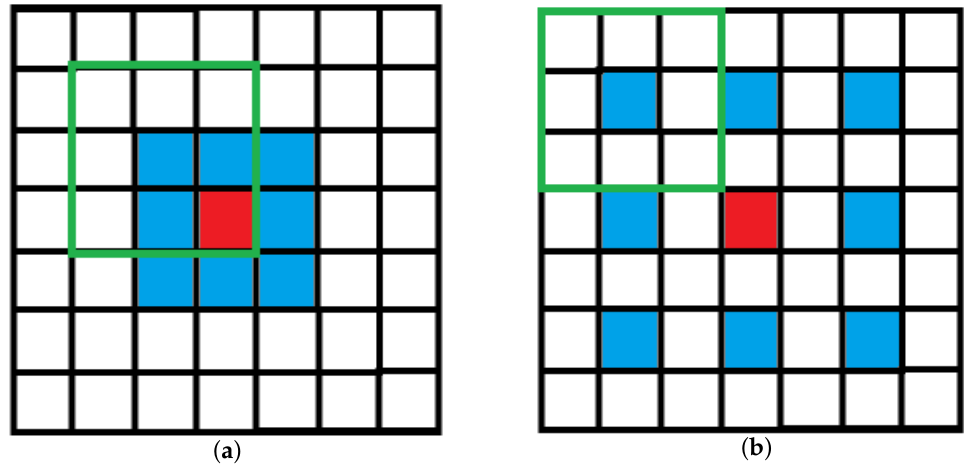
Figure 2. Dilated convolutional kernel has a bigger receptive field than normal convolutional kernel. ( a ) Normal 3 × 3 convolutional kernel; ( b ) dilated 3 × 3 convolutional